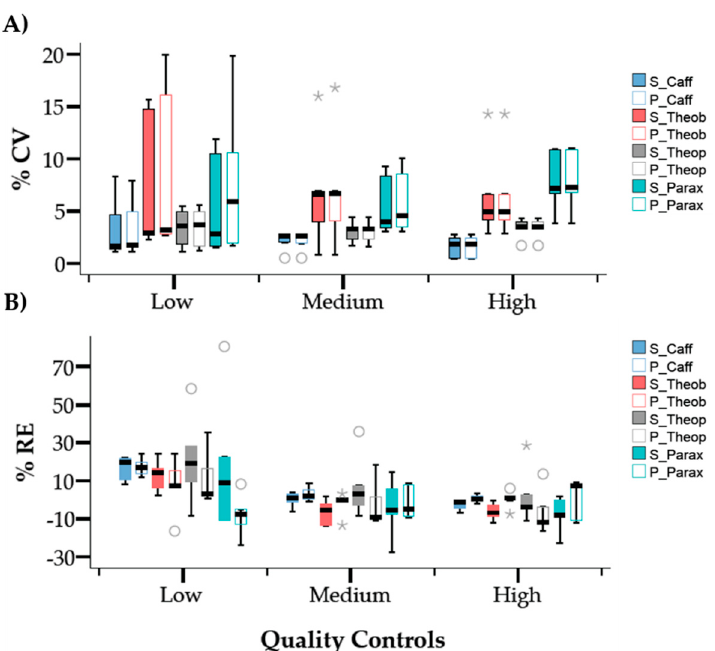
Figure 4. Box-plot representation for the results of the intra-day ( n = 3) ( A ) precision and ( B ) accuracy for caffeine, theobromine, theophylline, and paraxanthine determined using calibration curves prepared in solvent (S) and plasma (P). Results for the precision study are expressed as the percentage of coefficient of variation (%CV) and for accuracy as the percentage of relative error (%RE). Each box plot represents determinations for five days. The circles and asterisks are outliers that represent cases having values more than 1.5 or three times the height of the boxes (interquartile difference Q3-Q1), respectively.